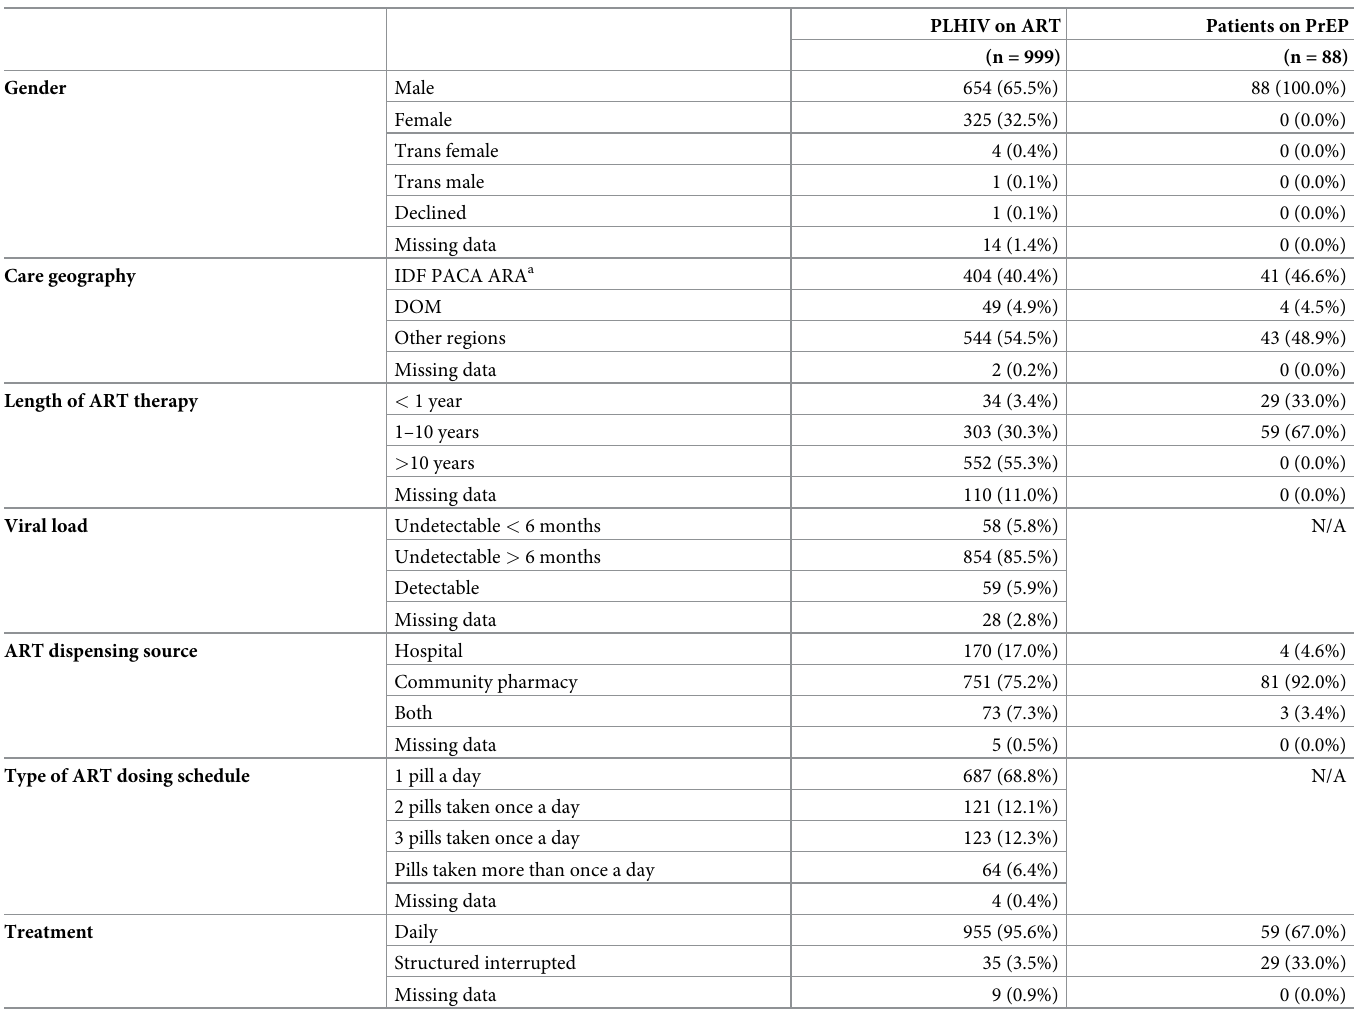
Table 1. Patients on ART—Demographics and medical